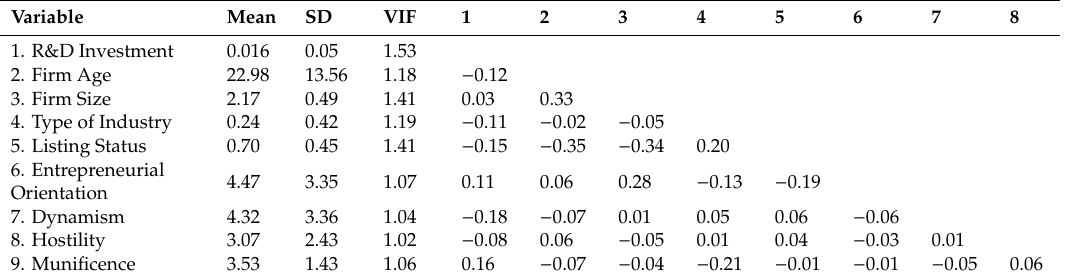
Table 2. Means, standard deviations, variance inflation factors (VIF), and Pearson correlations a .